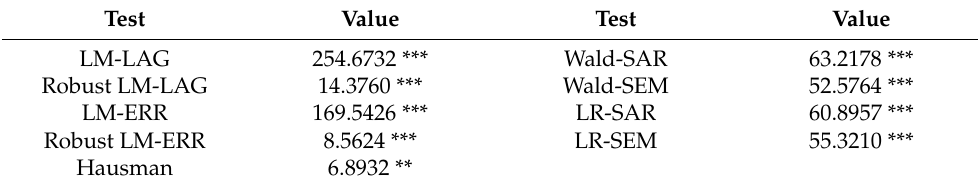
Table 7. The test results of LM, Wald, LR, and Hausman.